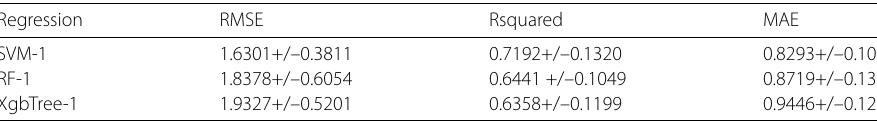
Table 1 Accuracy for regression with different models when k = 0.5 Regression RMSE Rsquared MAE SVM-1